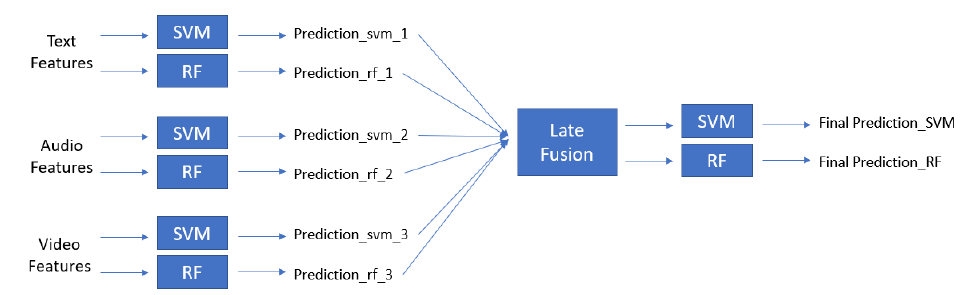
Figure 4. SVM and RF model architecture.